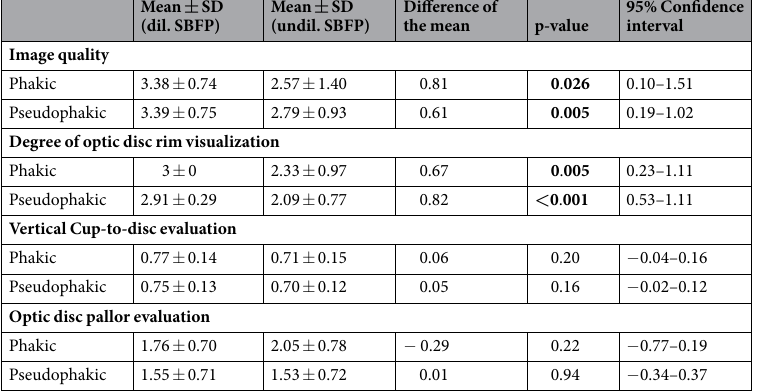
Table 3. Comparison of dilated and undilated smartphone-based fundus photography in phakic vs. pseudophakic eyes. CFP = conventional fundus photography; dil. = dilated; SBFP = Smartphone-based fundus photography; SD = standard deviation; undil. =